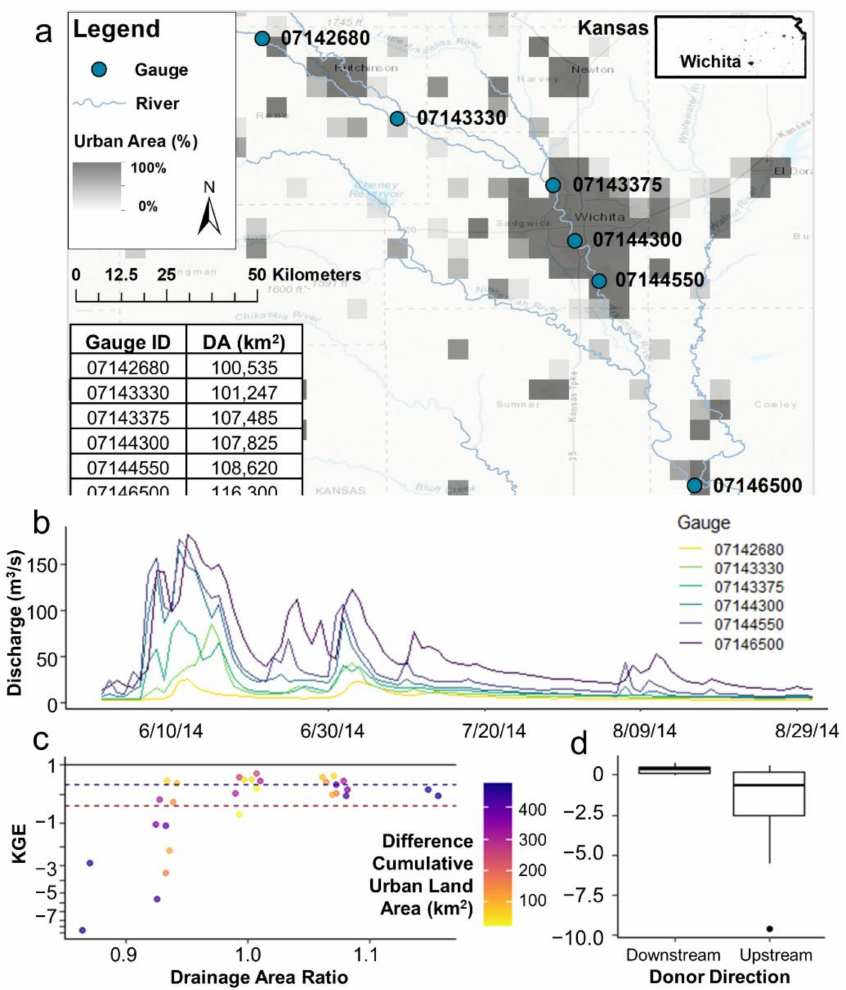
Figure 5. Case study of the effect of urbanization on discharge and Kling Gupta Efficiency (KGE) values. ( a ) Six gauges near Wichita, Kansas showing the percent of urban land area per 5 km 2 from MODIS satellite imagery in the area. USGS Gauge ID’s and drainage area are recorded, and drainage area ratios between the gauges span from 0.86 to 1.16. ( b ) Example of daily discharge time series from June to August 2014 for each gauge record. ( c ) KGE vs. drainage area ratio for all gauge interactions colored by the difference in cumulative urban land area (km 2 ) between the compared gauges. The black horizontal line at 1 indicates the optimal KGE value, the blue dashed line indicates the study’s defined “good” KGE value of 0.32, and the red dashed line is at KGE = − 0.41, the threshold for the metric where the model improves upon the mean flow benchmark. KGE is mapped using a pseudo log10 scale. ( d ) Boxplots of the KGE metrics according to the direction of donation from the donor